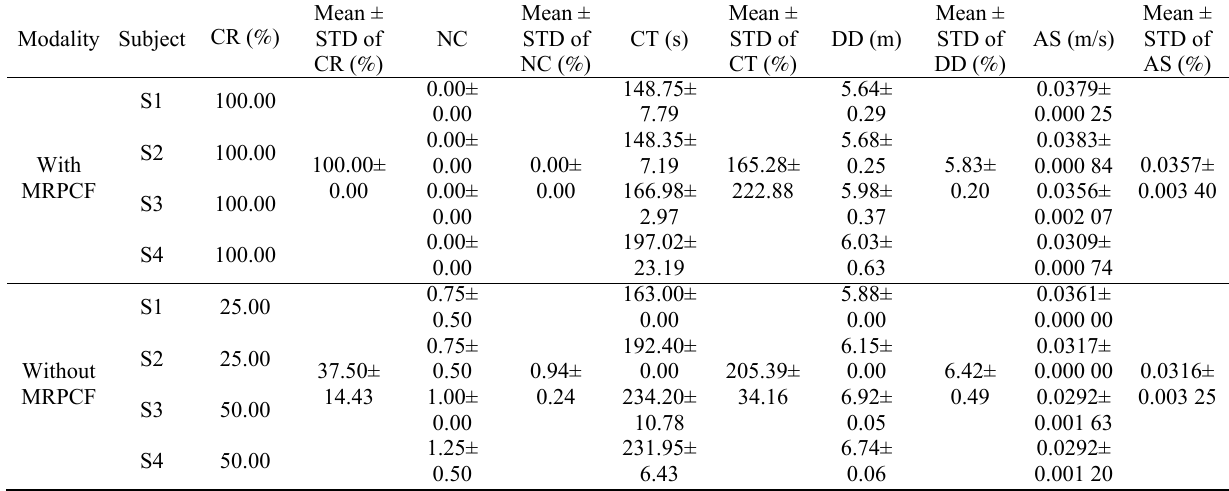
Table 3 Performance comparison of brain-controlled navigation tasks with and without MRPCF. Note that CR is task completion rate, NC is number of collisions, CT is task completion time, DD is driving distance, and AS is average speed. Modality Subject CR ( % )